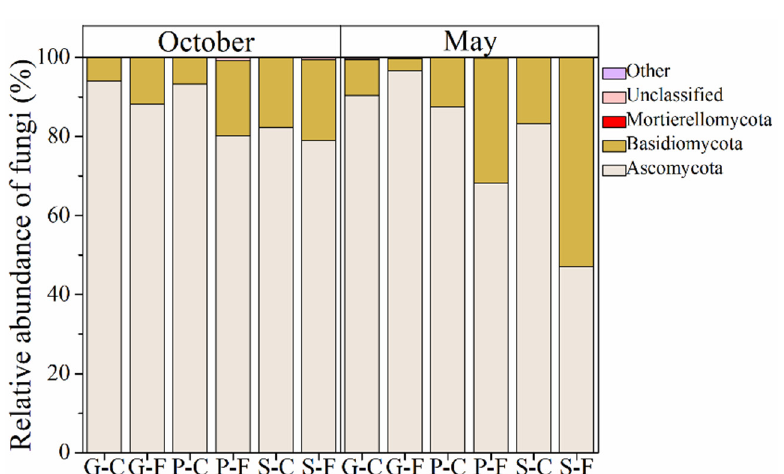
Figure A1. Overall relative abundance of leaf-associated fungi at phylum level of three types of plants from two locations over two seasons. G-C, G. biloba from campus; G-F, G. biloba from the forest; P-C, P. bungeana from campus; P-F, P. bungeana from the forest; S-C, S. chinensis from campus; S-F, S. chinensis from the forest.